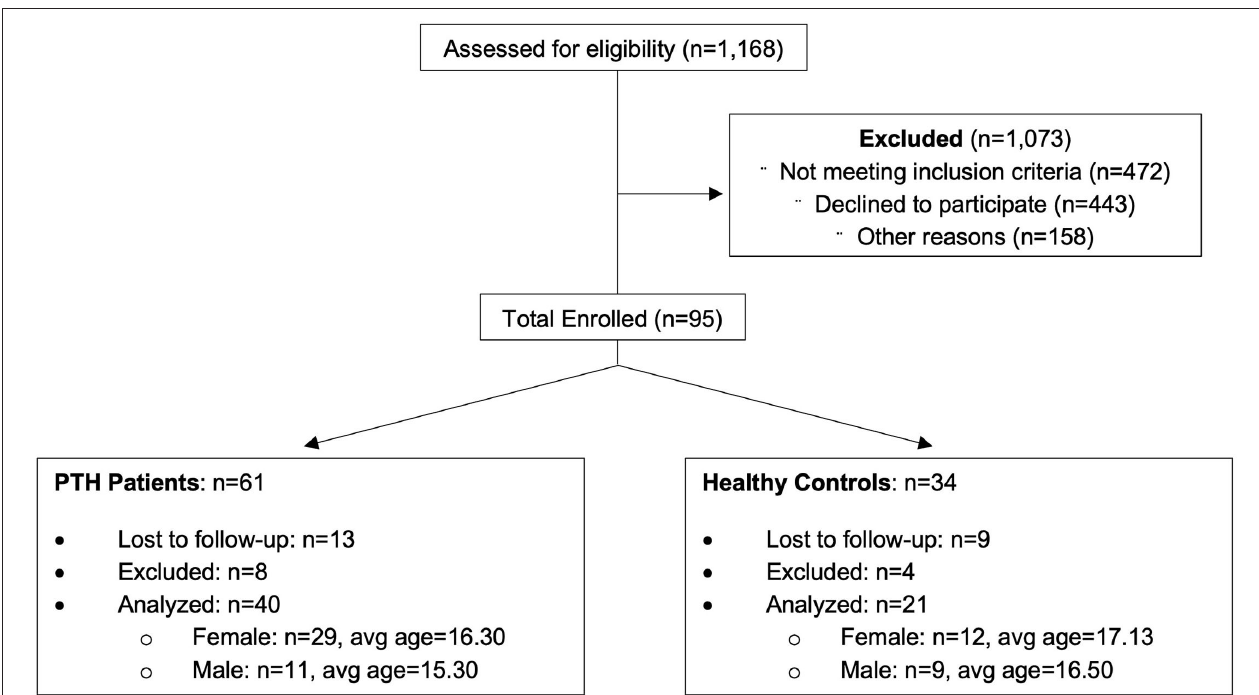
FIGURE 1 | Consort diagram showing included/excluded participants in this investigation.